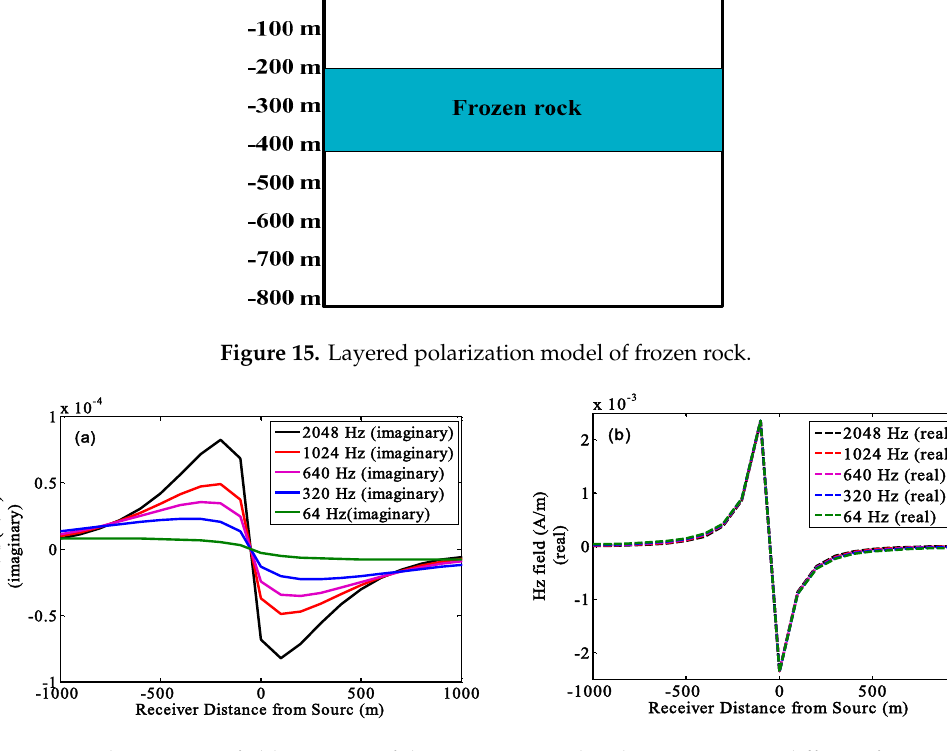
Figure 16. The magnetic field response of the imaginary and real components at different frequencies (( a ) imaginary part; ( b ) real part). Table 2. Extraction results of polarization parameters with layered model. Induced polarization (IP).